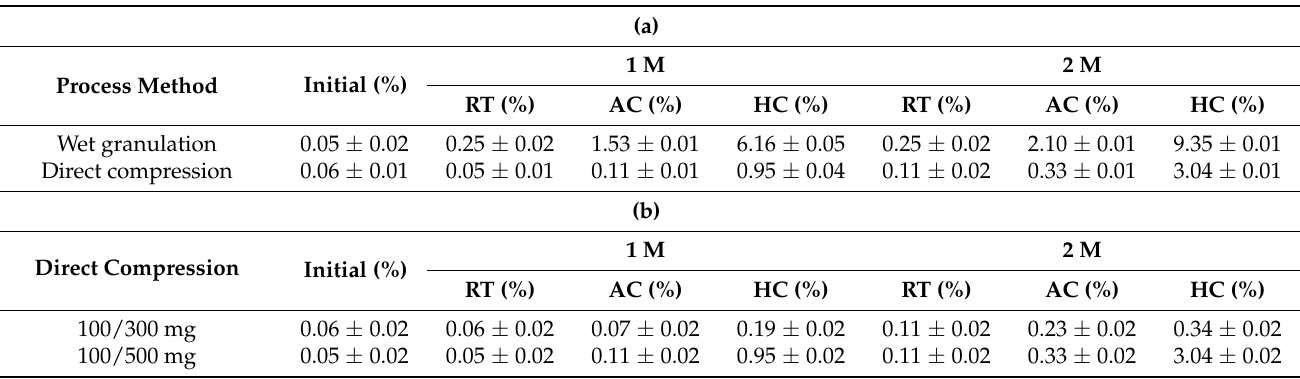
Table 4. (a) The stability of wet granulation and direct compression and (b) stability according to the ratio of excipients for 1 month.